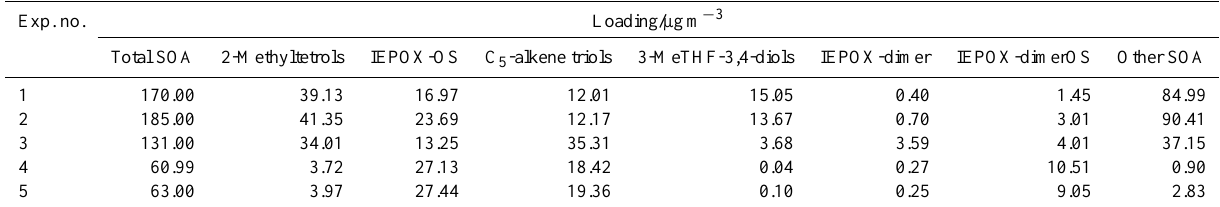
Table 2. Tracer mass loadings for each chamber SOA experiment. Exp. no.